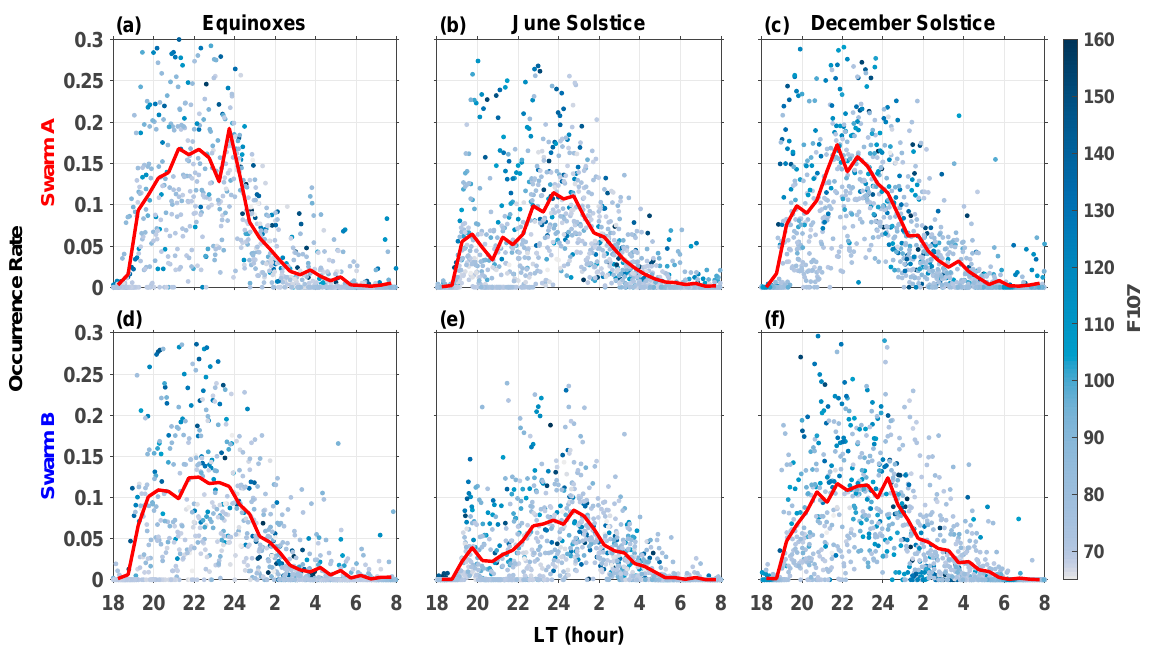
Figure 7. Variations of the plasma irregularity occurrence rate as a function of LT by RODI for different F107 and satellites near the geomagnetic equator ( ± 10 ◦ ). The panels from left to right show results during the equinoxes ( a , d ), June solstice ( b , e ), and December solstice ( c , f ), from top to bottom show results for Swarm A and Swarm B. The red lines display the 0.5 h averaged variation of the occurrence. Each dot indicates the average daily occurrence and local time of the satellite’s ascending and descending orbits.